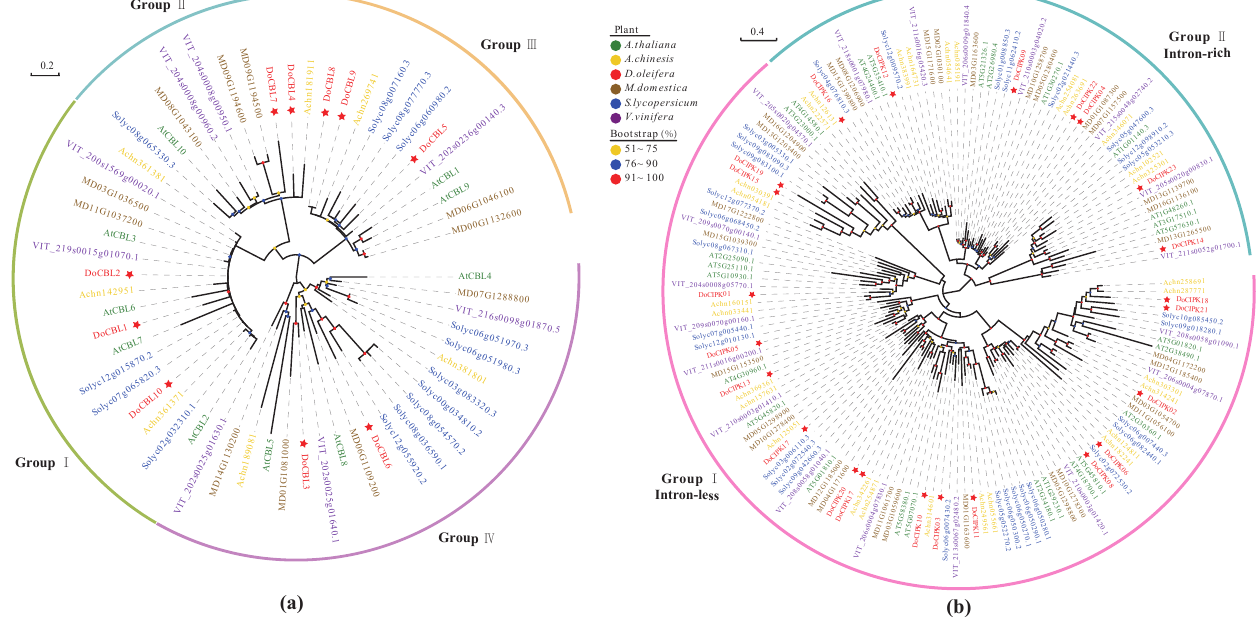
Figure 1. Phylogenetic trees of CBL proteins ( a ) and CIPK proteins ( b ) from Diospyros oleifera , Arabidopsis thaliana , Actinidia chinensis , Malus domestica , Solanum lycopersicum and Vitis vinifera . The different colored arcs indicate different groups. Proteins from the six plants are denoted by different colors. Node support values (pots) are quantified by approximate likelihood ratio test (aLRT) statistics with the SH–like procedure. DoCBLs and DoCIPKs are marked with red